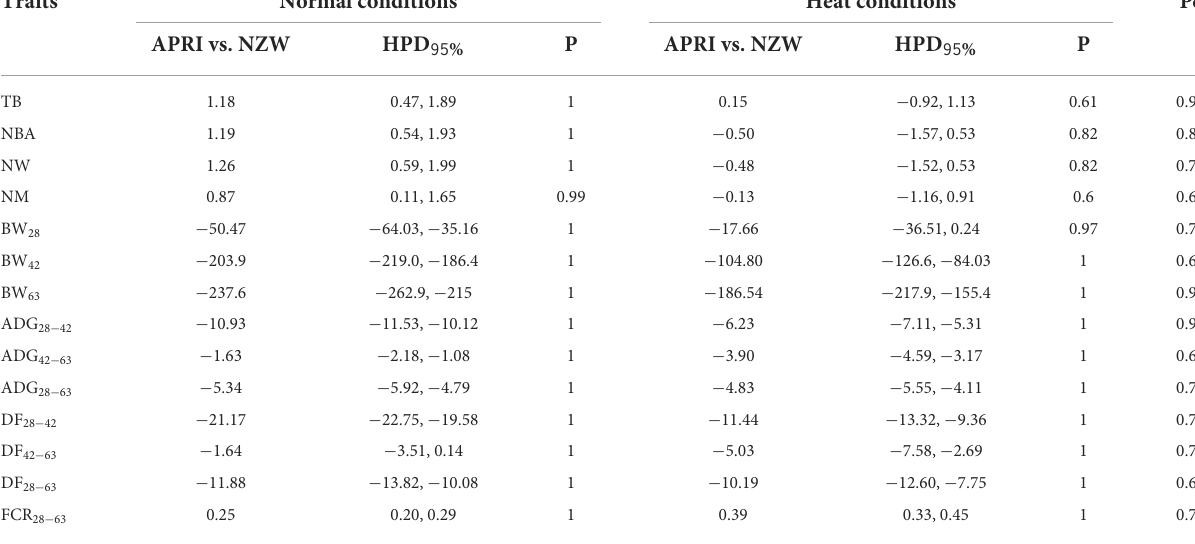
TABLE 4 Effects of genotype by heat interaction on litter and growth traits. Traits Normal conditions Heat